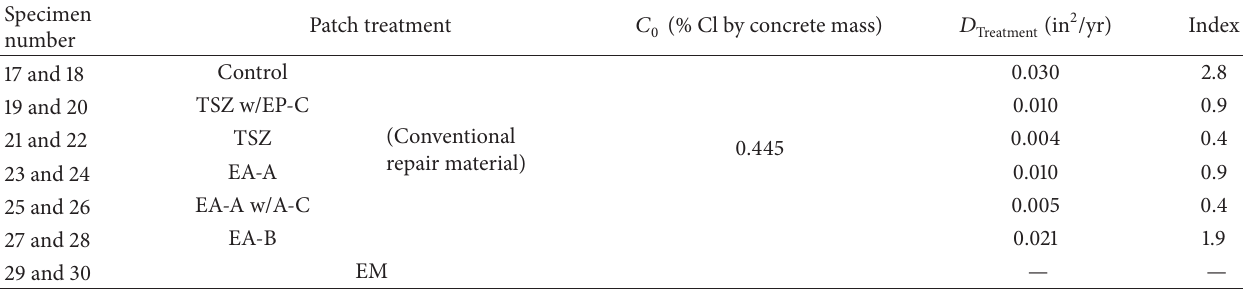
Table 6: Calculated chloride diffusion coefficients for patch materials of CoC specimens at the conclusion of project (1 inch = 25.4 mm). Specimen